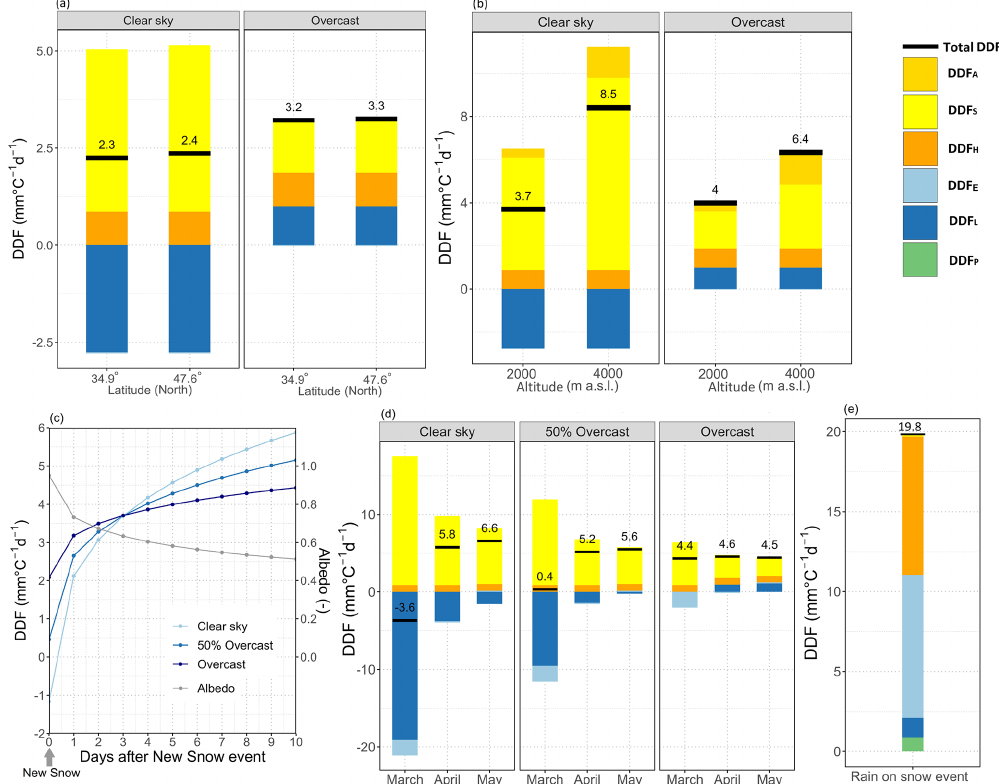
Figure 10. Influence of (a) latitude, (b) altitude, (c) albedo, (d) season, and (e) rain on snow events on the DDF under clear-sky and overcast conditions. DDF components: shortwave radiation (DDF S ), longwave radiation (DDF L ), sensible heat (DDF H ), latent heat (DDF E ), precipitation heat (DDF P ) and increase in shortwave component due to the increase in the clearness index with altitude (DDF A